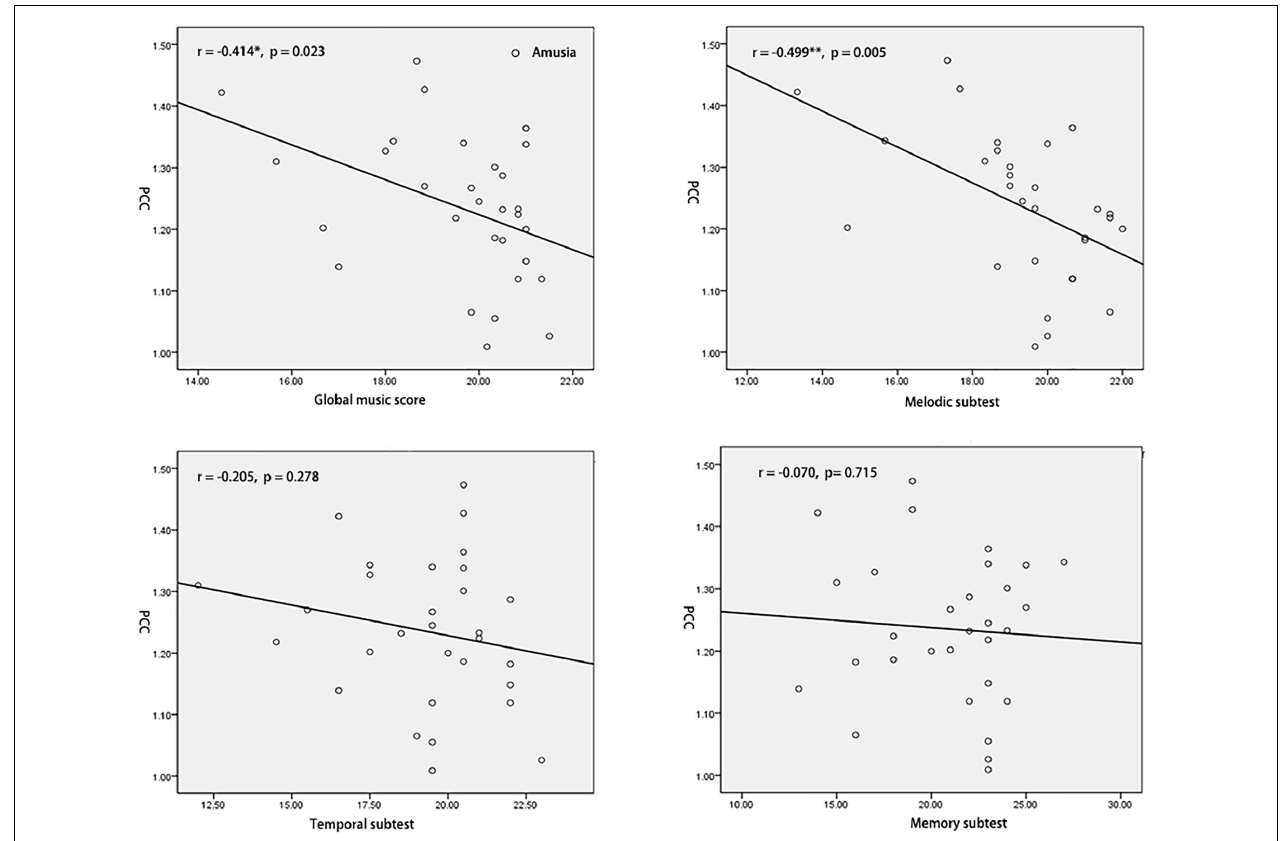
FIGURE 3 | Correlation analyses between the mean value of PCC and MBEA scores in amusia group. * p < 0.05, ** p <